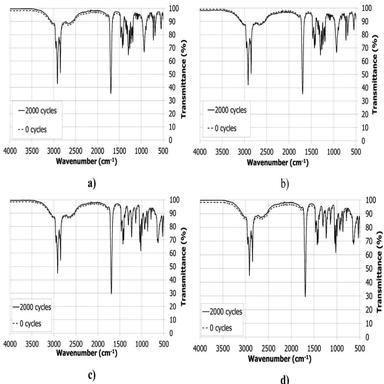
IR spectrums: a) CA b) CA with 1.0 wt.% nSiO2 c) CA–MA d) CA–MA with 1.0 wt.% nSiO